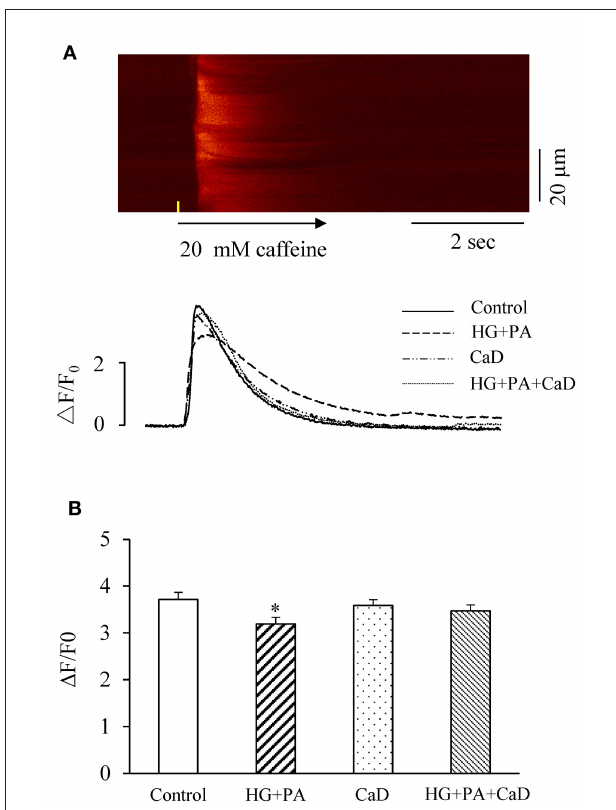
FIGURE 2 | HG + PA reduces SR Ca 2 + content in cardiomyocytes. (A) Representative confocal image in control and representative time-courses of caffeine-elicited Ca 2 + transient traces in Control, HG + PA, CaD, and HG + PA + CaD. (B) Average SR Ca 2 + contents indicated by the amplitude of caffeine-elicited Ca 2 + transient ( 1 F/F0) in Control, HG + PA, CaD, and HG + PA + CaD. * p < 0.05 vs. control. n = 10–20.